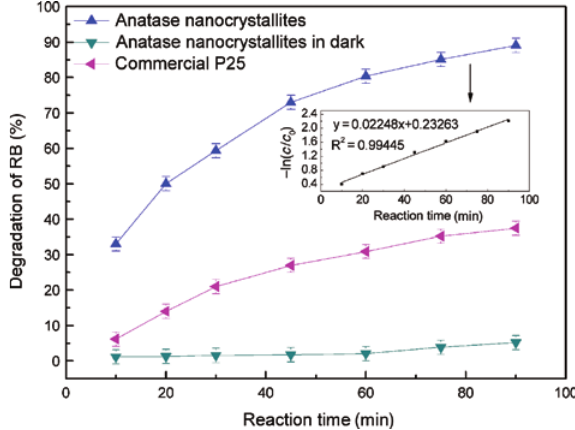
Figure 6: The degradation and fitting results of the RB using different catalysts.